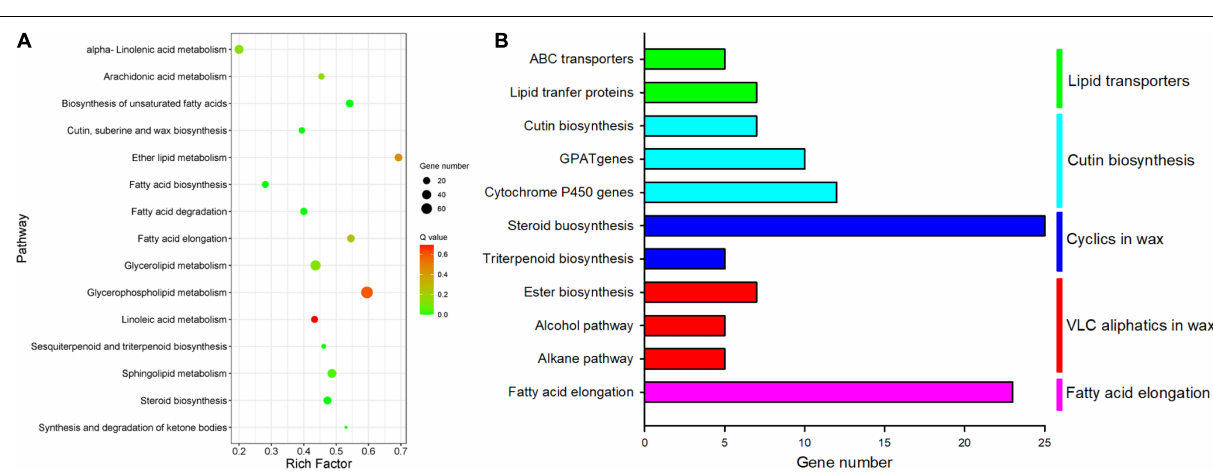
FIGURE 7 | Enriched KEGG pathways involved lipids and cuticle metabolisms. (A) Scatter plot of enriched in lipid metabolisms; the rich factor is the ratio of the number of DEGs in each lipid pathway to the total DEGs involved in lipid metabolisms (0–1). (B) The number of differential cuticle-related genes in the five main cuticle biosynthesis